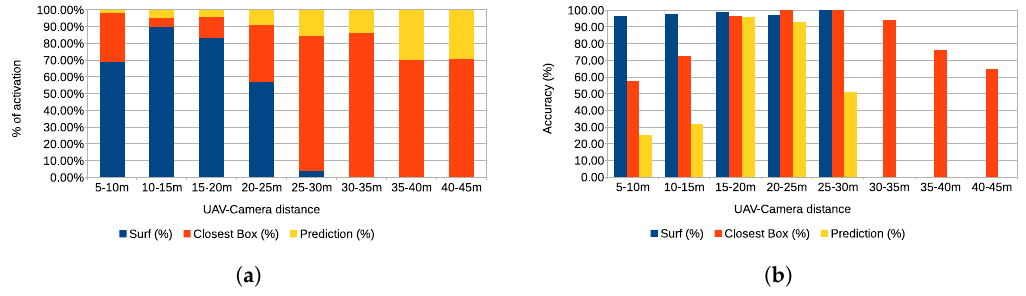
Figure 15. Vision-based UAV detection performance. ( a ) Frequency of activation; ( b )